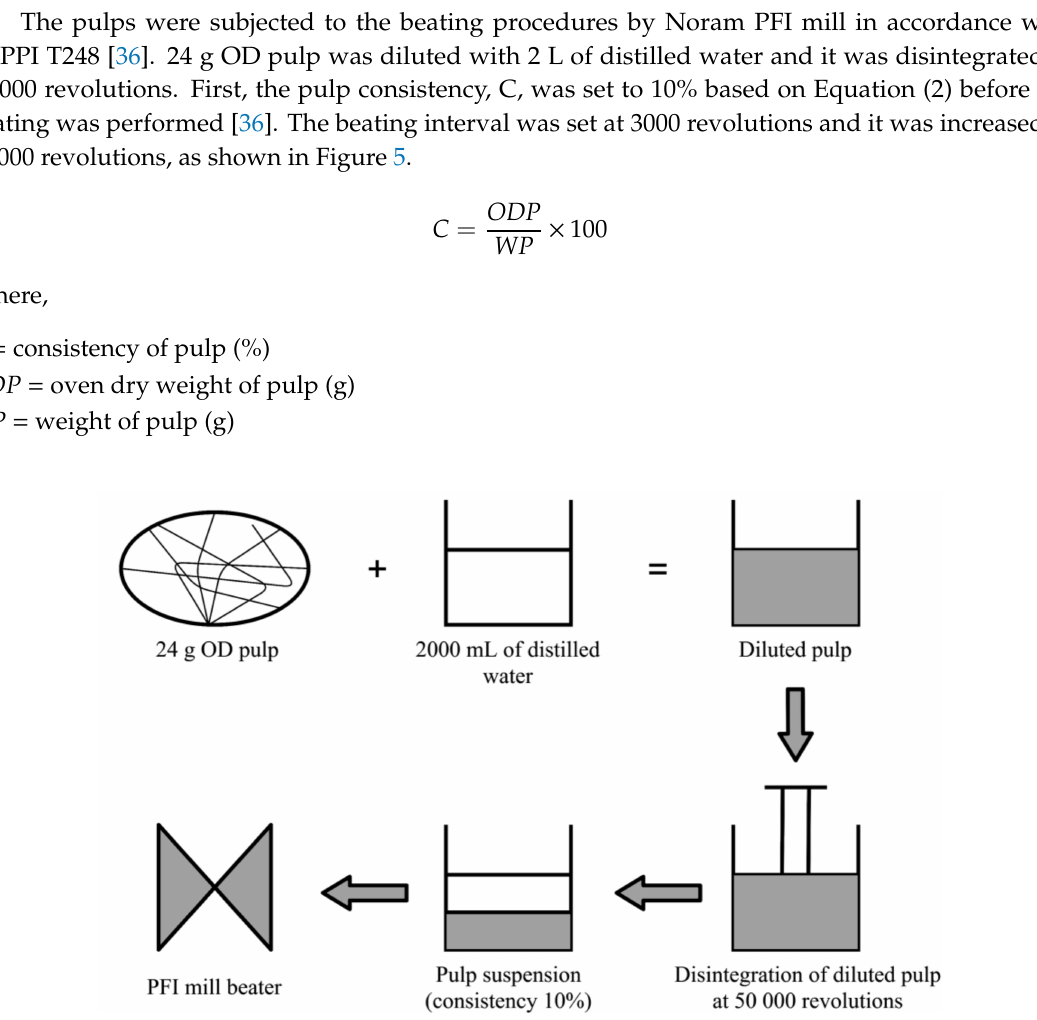
Figure 5. Beating process of the Kenaf